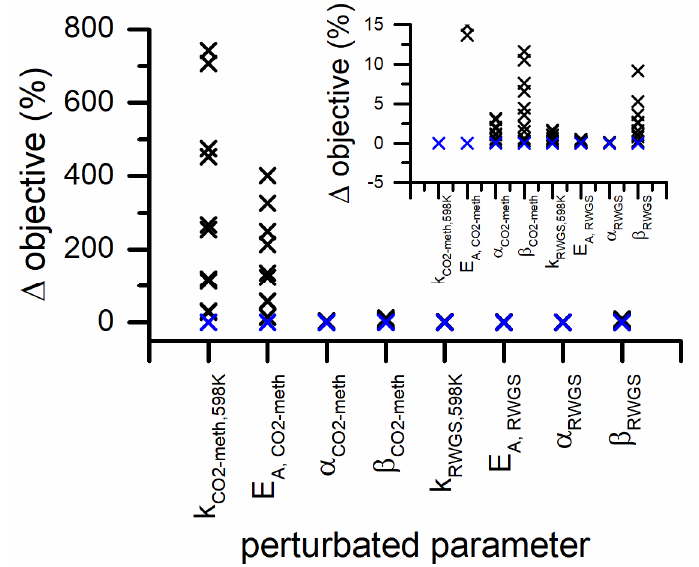
Figure 8. Parameter sensitivity analysis for PL kinetic model (blue symbols represents the 0% variation and the black symbols represent the 5% variation steps). The inset is a zoom of the y-axis in the 0–15% range.